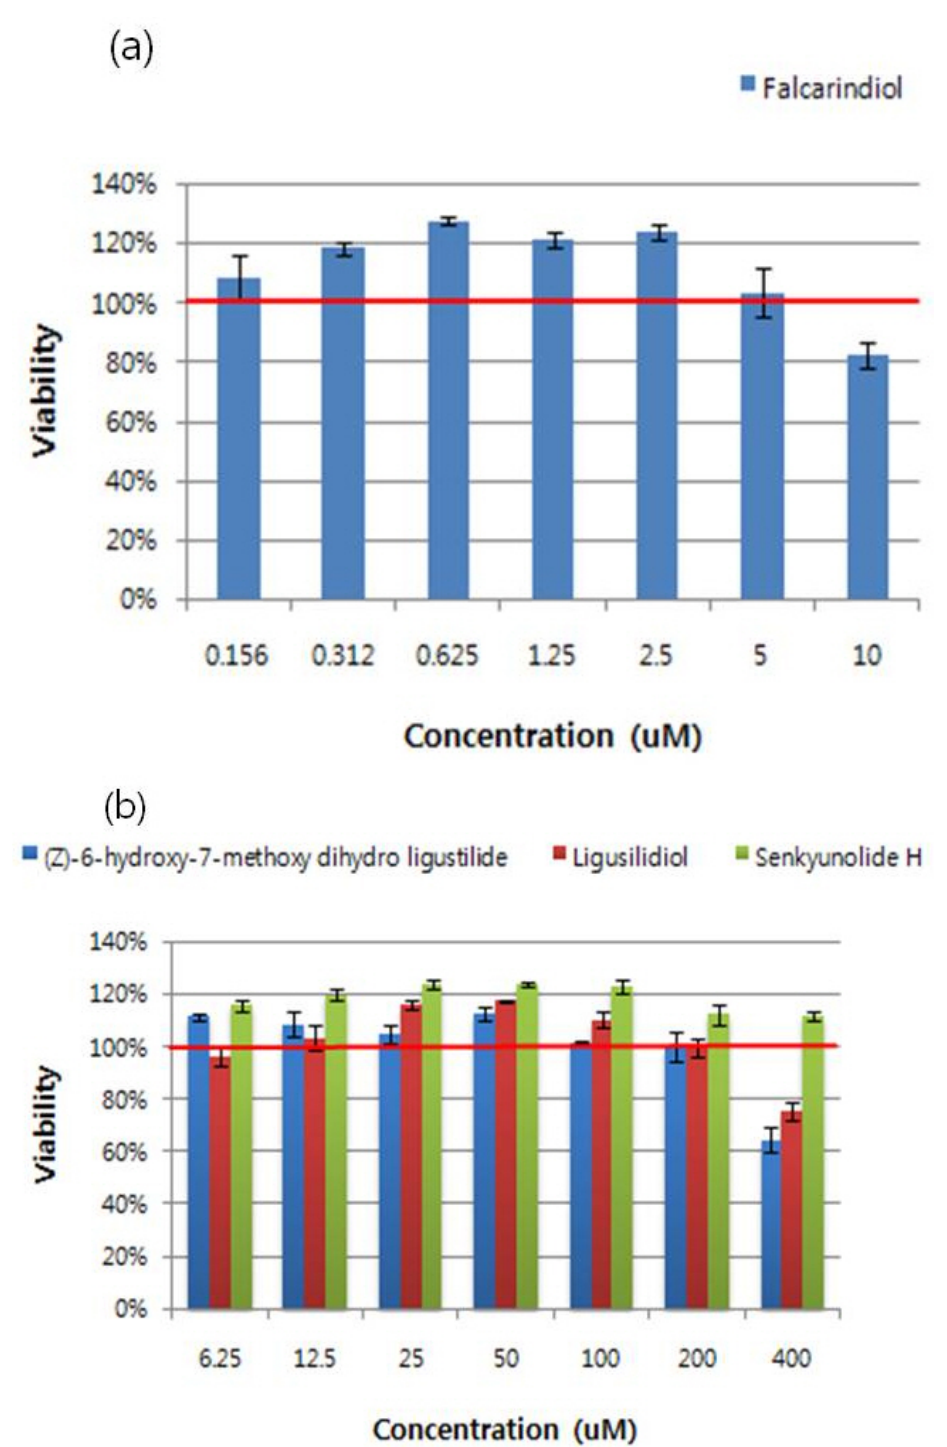
Figure 2. Cell cytotoxicity of RAW 264.7 cells by treatment of compounds. An examination of the cytotoxicity of four compounds on RAW 264.7 cells was evaluated by the MTT assay. Measuring cytotoxic effect each experiment was performed in triplicates and repeated at least three times. ( a ) Falcarindiol; ( b ) ( Z )-6-hydroxy-7-methoxy- dihydroligustilide, Ligusilidiol, Senkyunolide